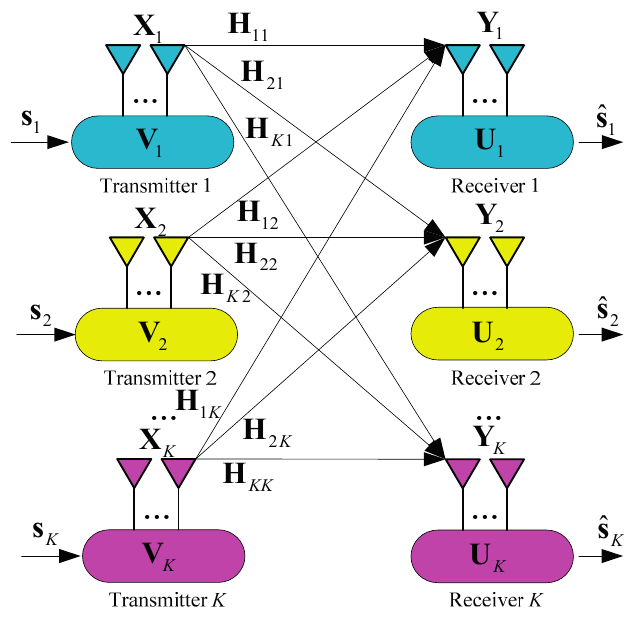
Figure 1. System model of the K -user MIMO interference